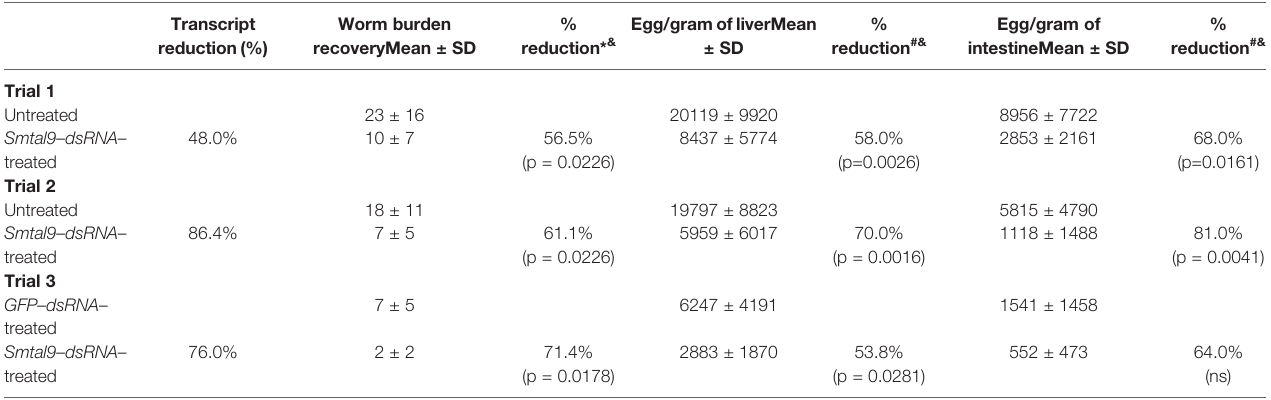
TABLE 2 | Worm burden recovery from mice infected with schistosomula knocked – down Smtal – 9 expression. Transcript